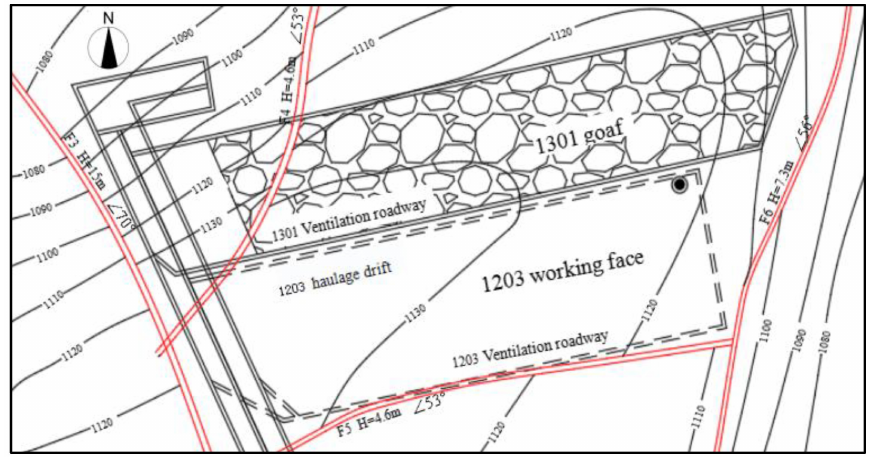
Figure 2. Working face layout